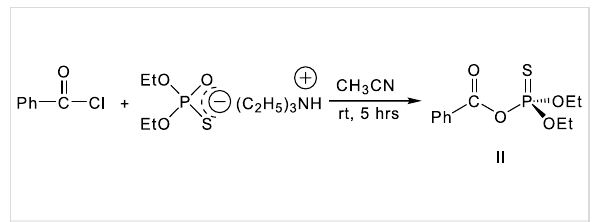
Scheme 6: Reaction of triethylammonium O,O '-diethyl thiophosphate with benzoyl